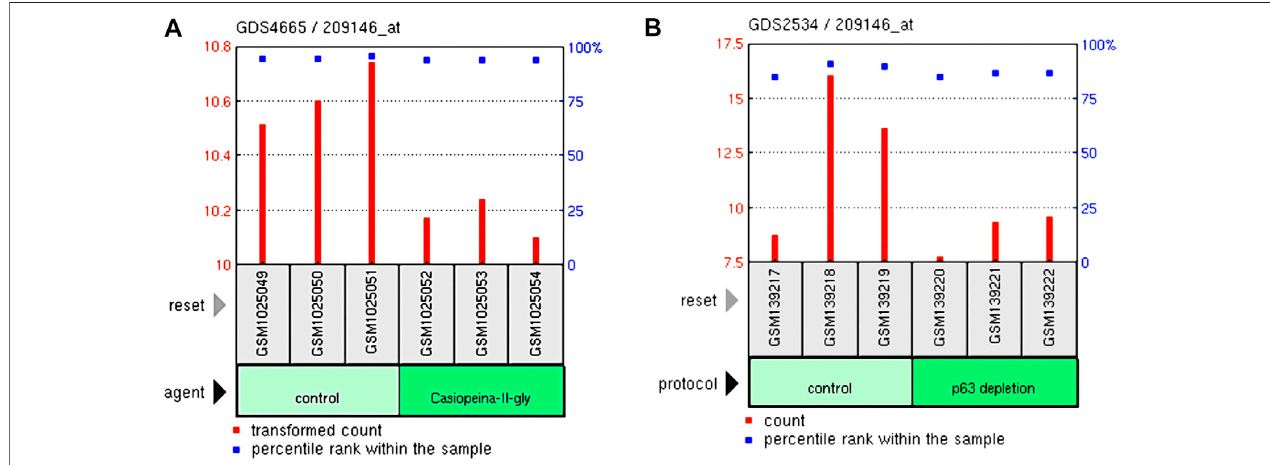
FIGURE 15 | The relationship of the expression of MSMO1 and Casiopeinas chemotherapeutics and P63 loss in CESC. (A) Casiopeinas chemotherapeutics affected the expression of MSMO1 in GDS4665/209146. (B) P63 loss affected the expression of MSMO1 in